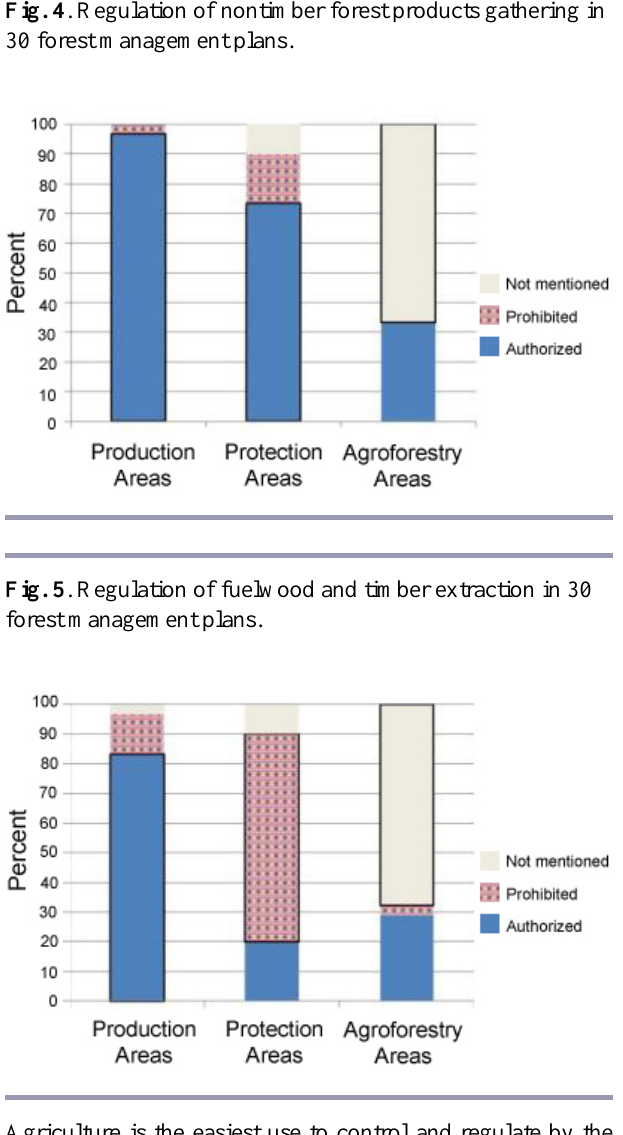
Fig. 4 . Regulation of nontimber forest products gathering in 30 forest management plans.